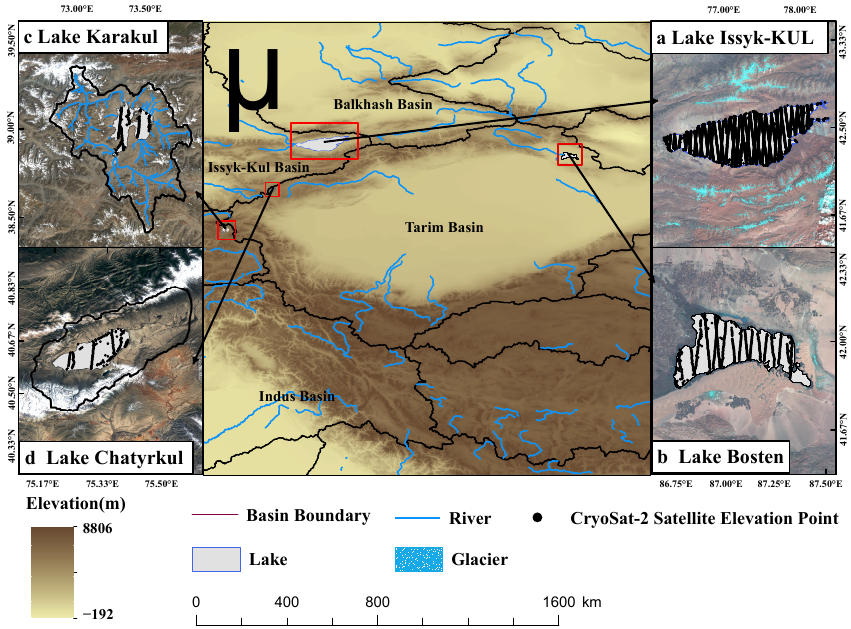
Figure 1. The geographical location of the lakes in the study area.